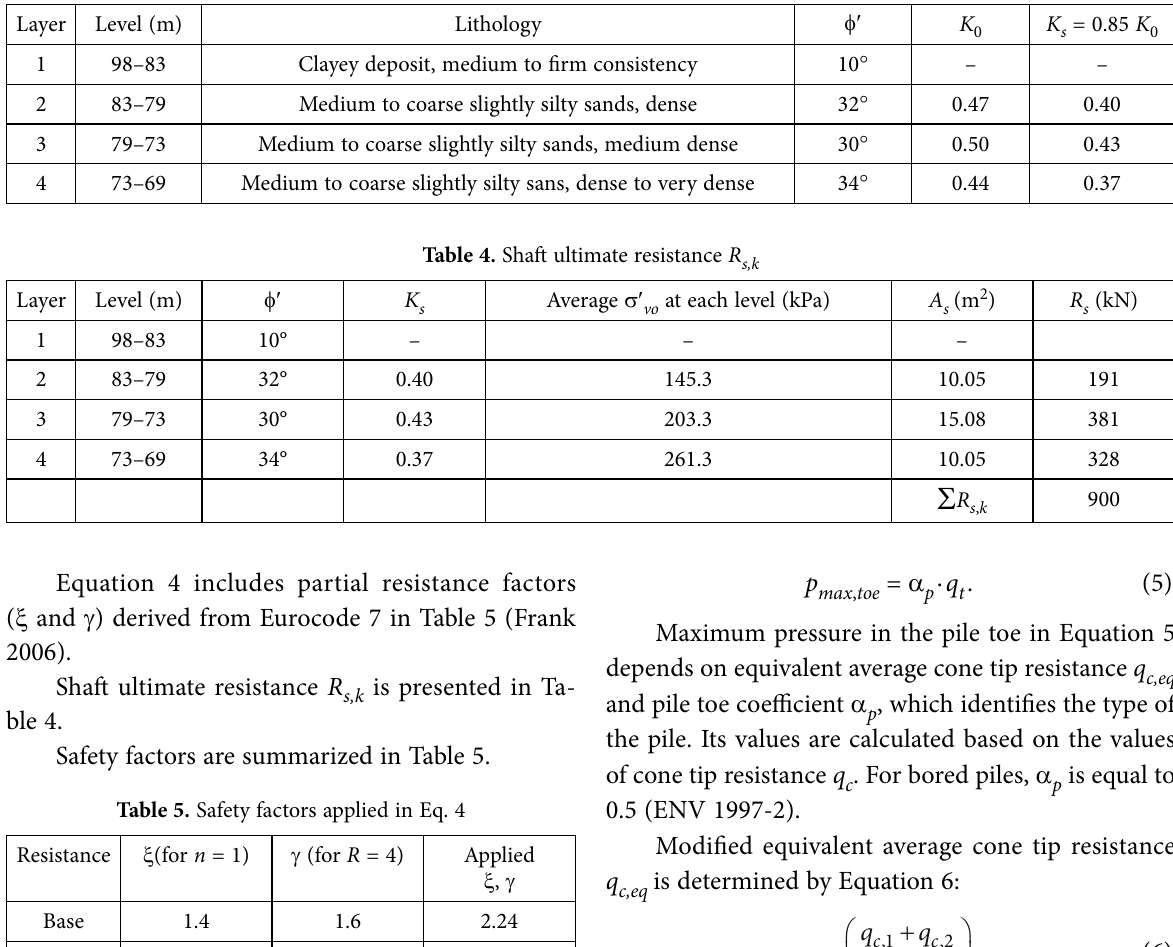
= 1 – sin (cid:73)(cid:99) ) 0